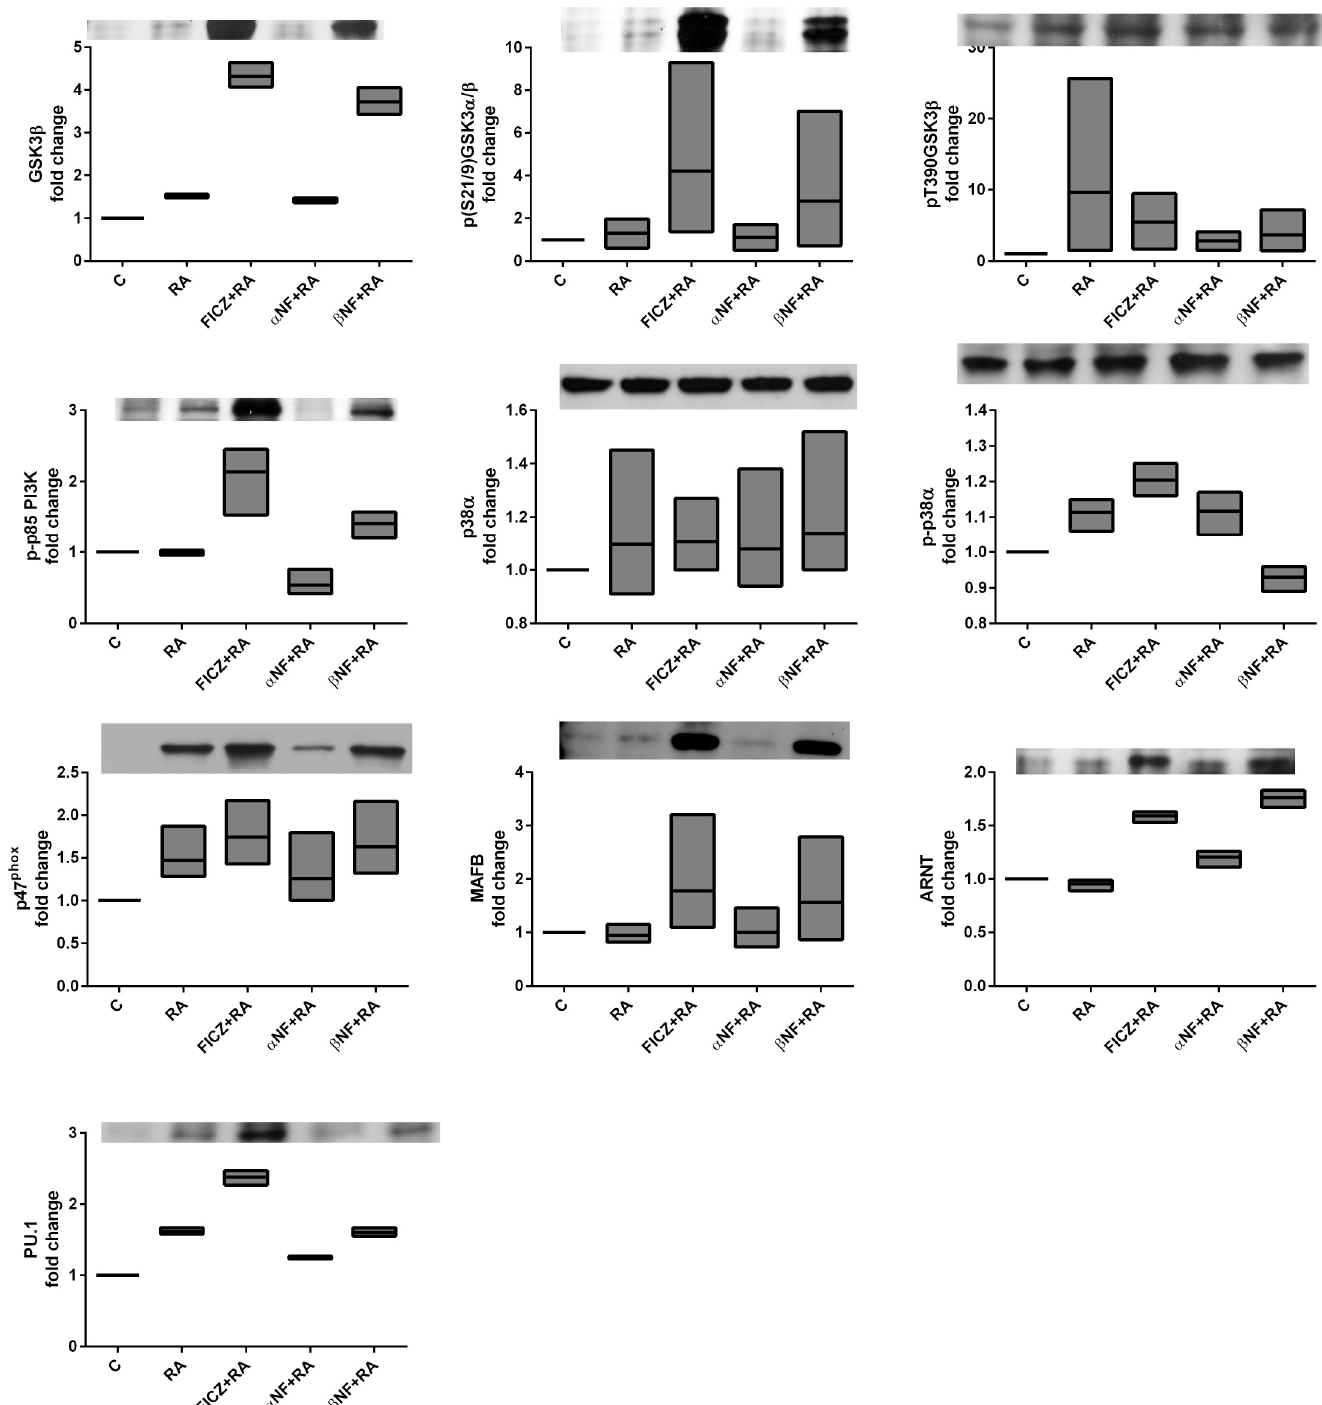
Fig 6. FICZ modulates RA-elicited signalsome. HL-60 cells were cultured and treated as described in Fig 5. Western blots for GSK3 β , p(S21/9)GSK3 α / β pT390GSK3 β , p-p85 PI3K, p38 α , p-p38 α , p47 phox , MAFB, ARNT, and PU.1 was performed as described in Fig 5.